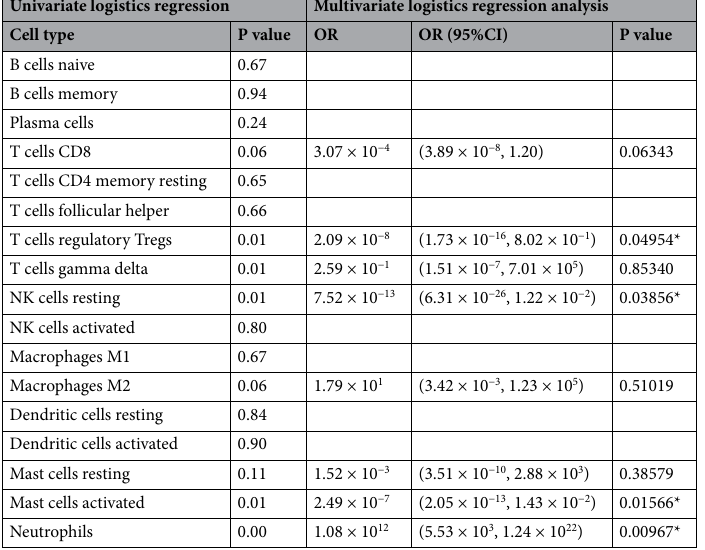
Table 2. Logistics regression analysis.